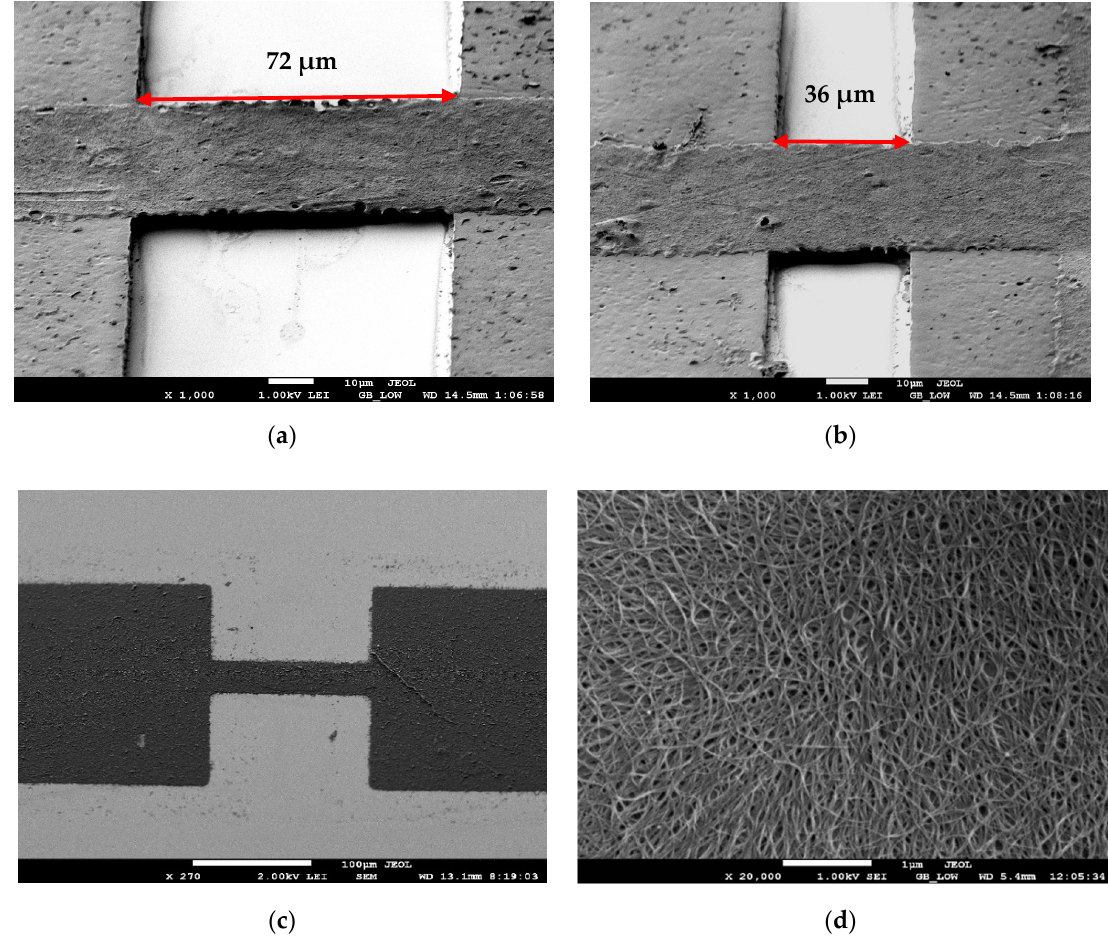
Figure 2. ( a ) and ( b ) suspended beams with different suspension lengths, ( c ) a normal non-suspended nanotube beam, and ( d ) networks of nanotubes that comprise the beam.